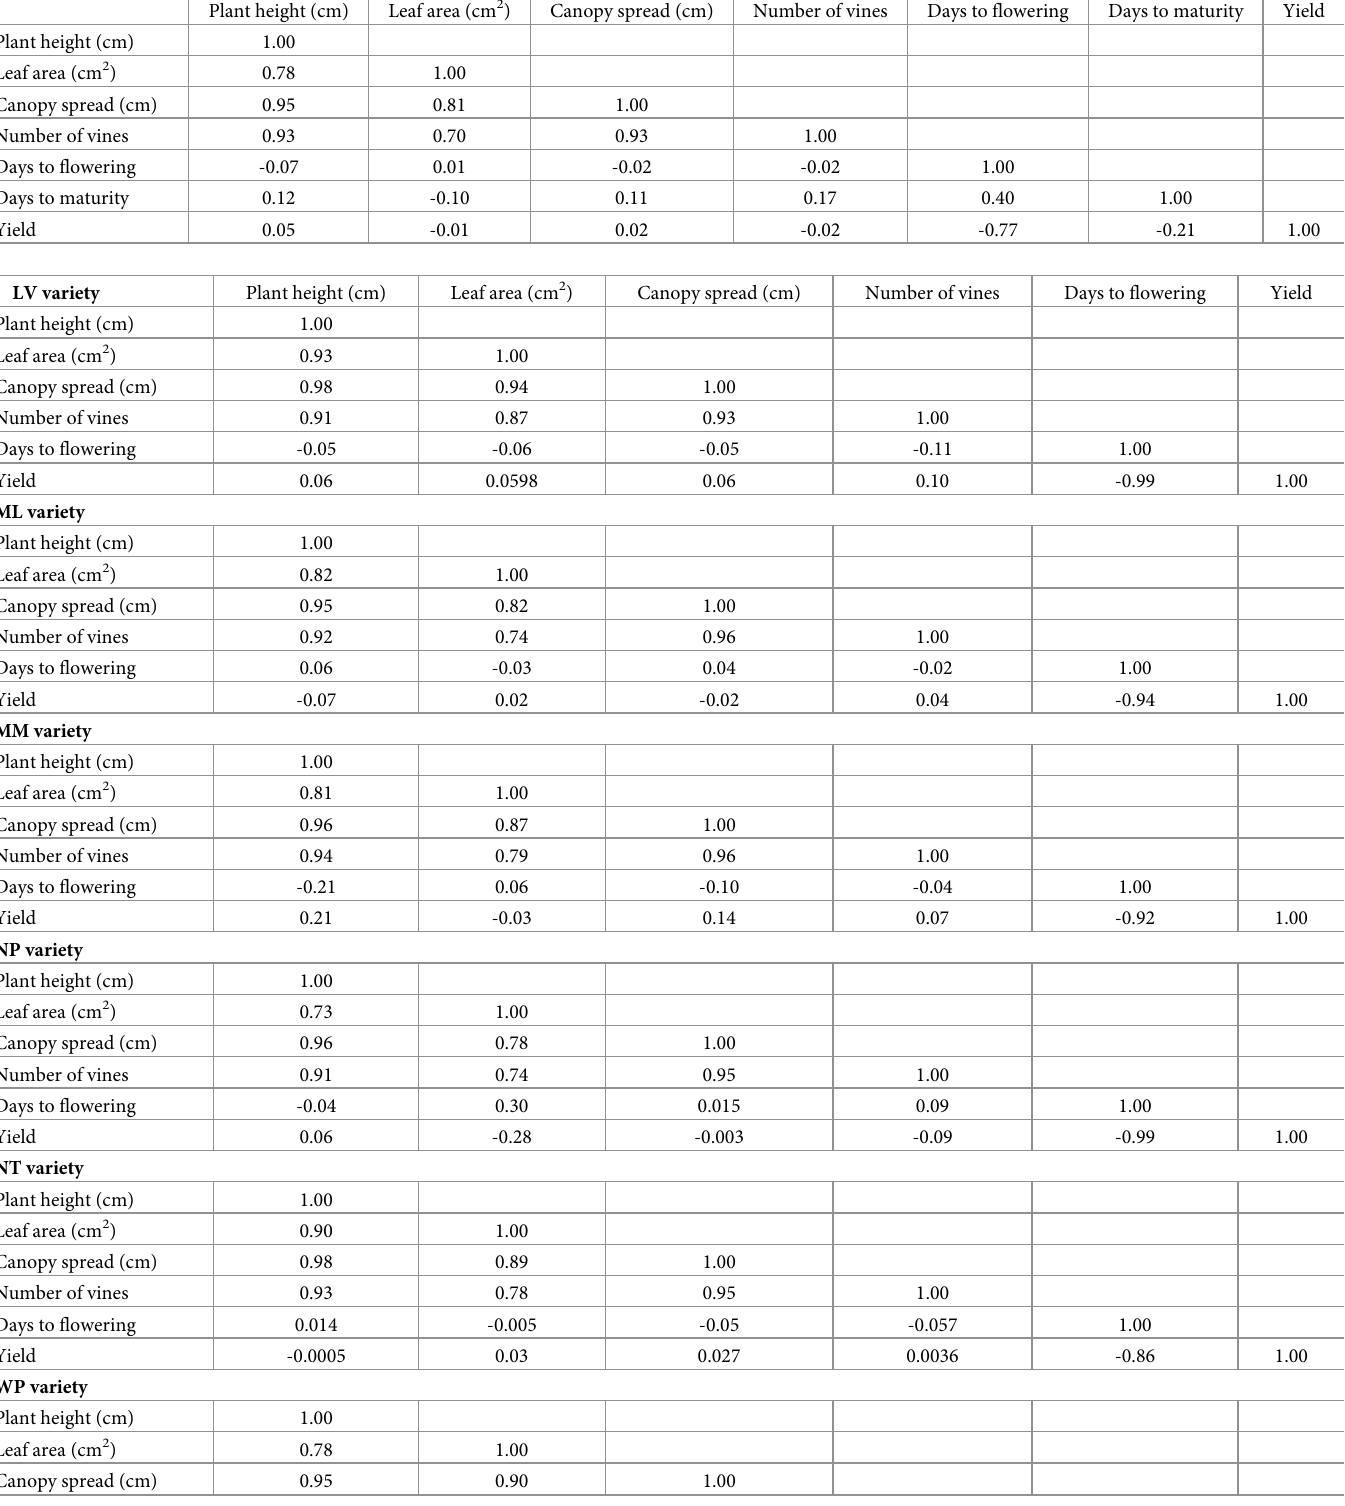
Table 3. a: Mean correlation of growth parameters to each other and to crop yield. b: Correlation of growth parameters to each other and to yield in the